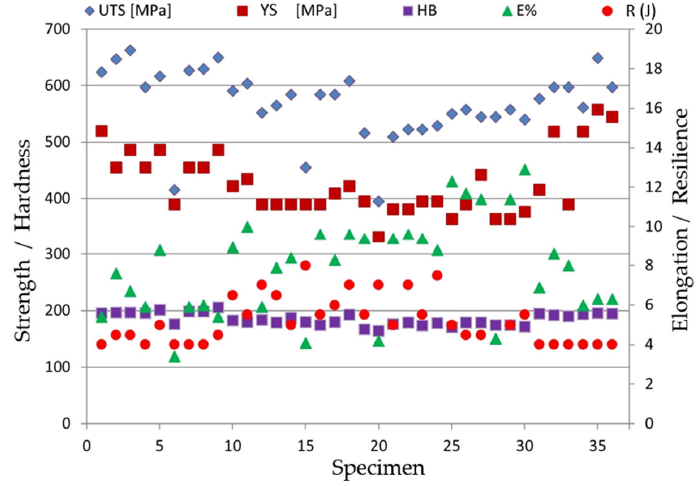
Figure 6. Mechanical properties of the UTS (MPa), YS (MPa), HB , ε (%) and R (J) for each specimen.